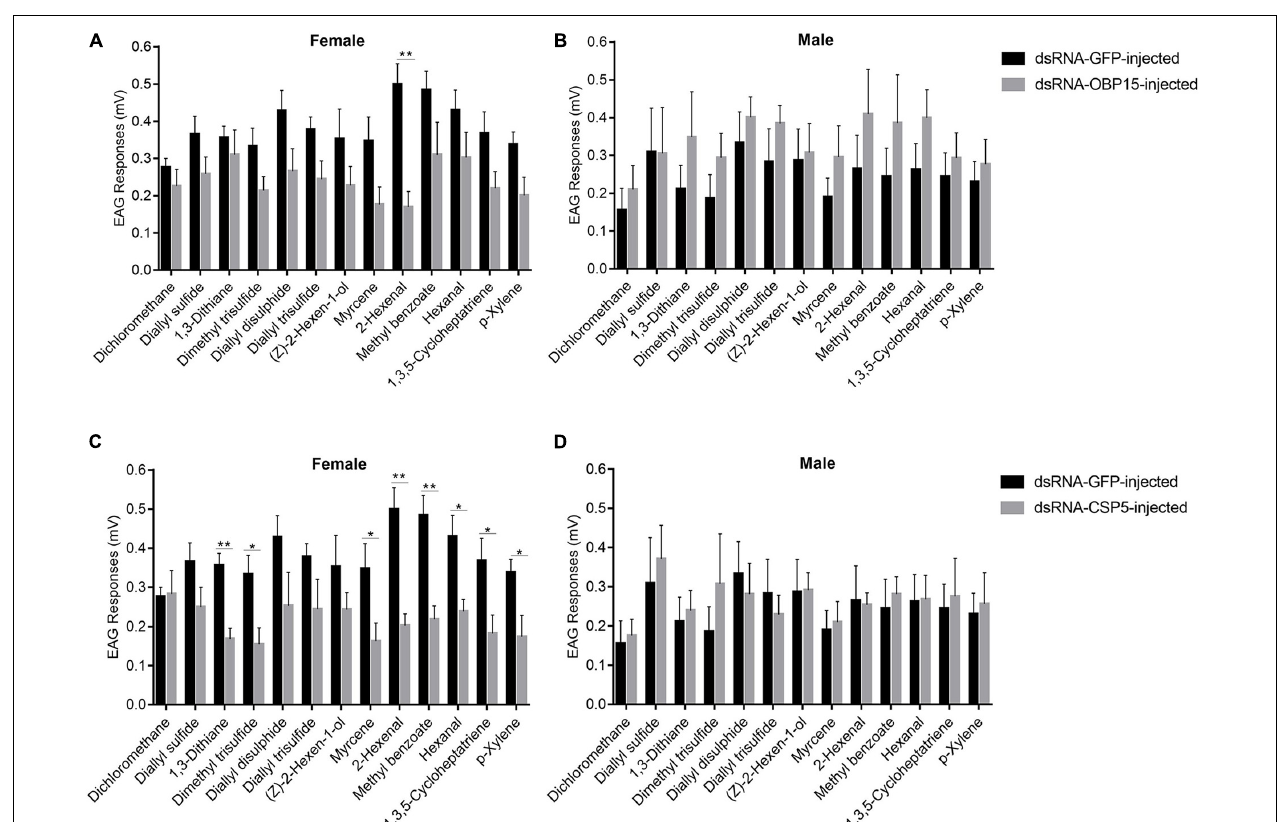
FIGURE 6 | EAG responses of dsRNA-GdauOBP15-injected (A,B) and dsRNA-GdauCSP5-injected (C,D) in G. daurica female and male to various compounds ( t -test; * P < 0.05; ** P < 0.01). Columns indicate the mean ± standard error of six independent experiments.